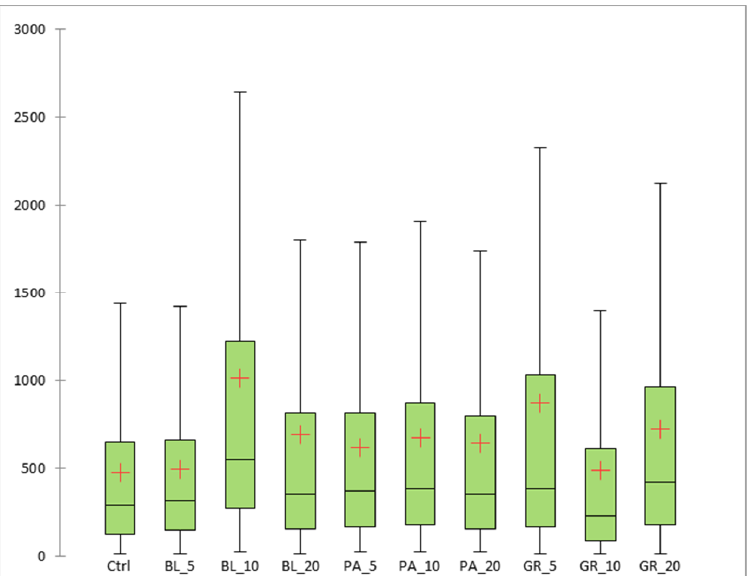
Figure 6. The results of SEM of edible coatings: the size of the cracks (fissure area) in the surface of the coatings [nm 2 ] (BL_5, edible coating with 5% of blueberry extract; BL_10, edible coating with 10% of blueberry extract; BL_20, edible coating with 20% of blueberry extract; GR_5, edible coating with 5% of red grape extract; GR_10, edible coating with 10% of red grape extract; GR_20, edible coating with 20% of red grape extract; PA_5, edible coating with 5% of parsley extract; PA_10, edible coating with 10% of parsley extract; PA_20, edible coating with 20% of parsley extract; Ctrl, control = edible coating without added extract).